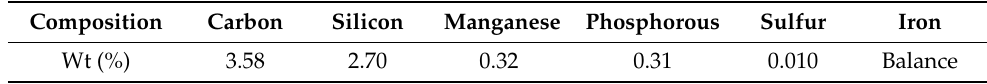
Table 1. Chemical properties of ductile cast iron.